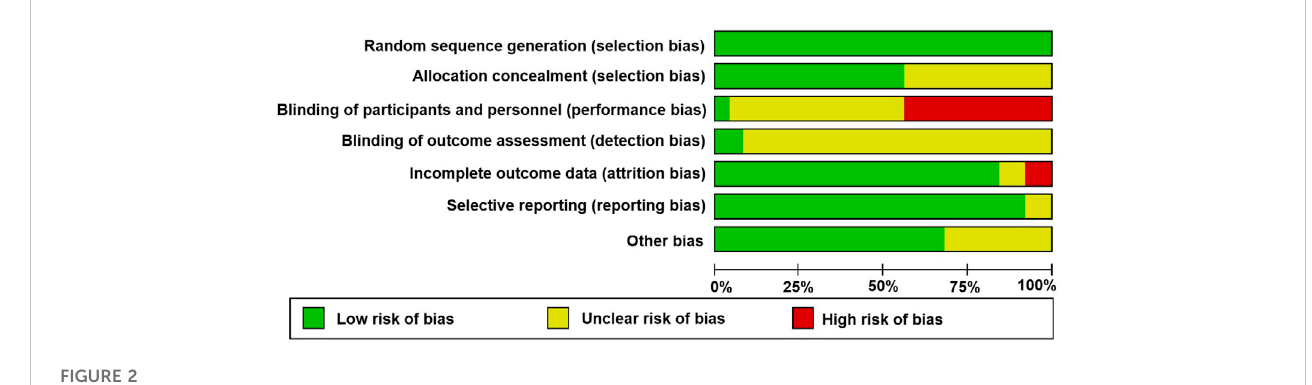
FIGURE 2 Risk of bias.